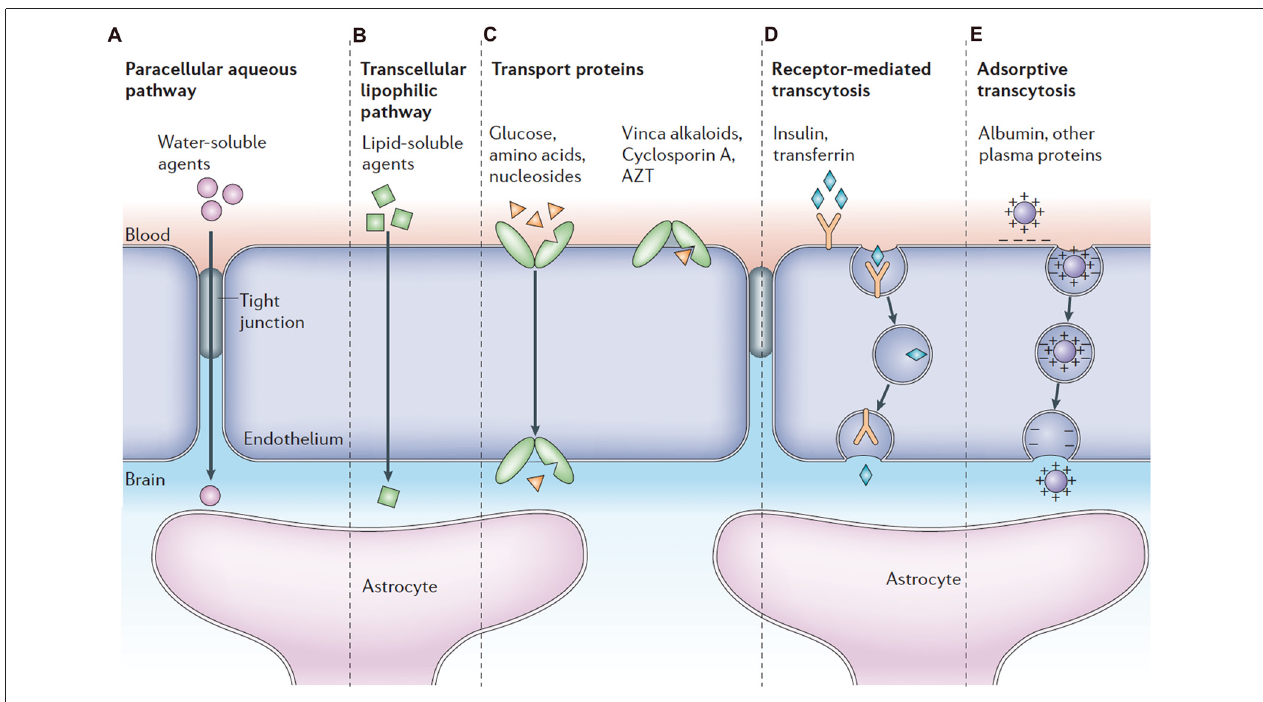
FIGURE 2 | Pathways across the blood-brain barrier (BBB). Modified with permission from Abbott et al.